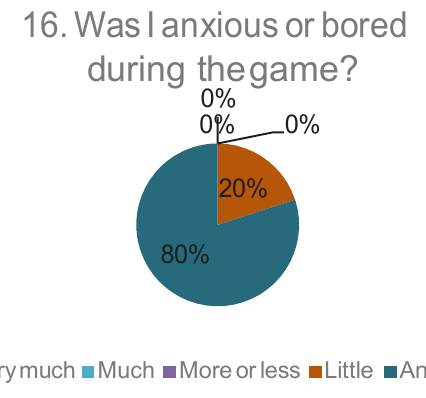
Figure 8. Game clear.